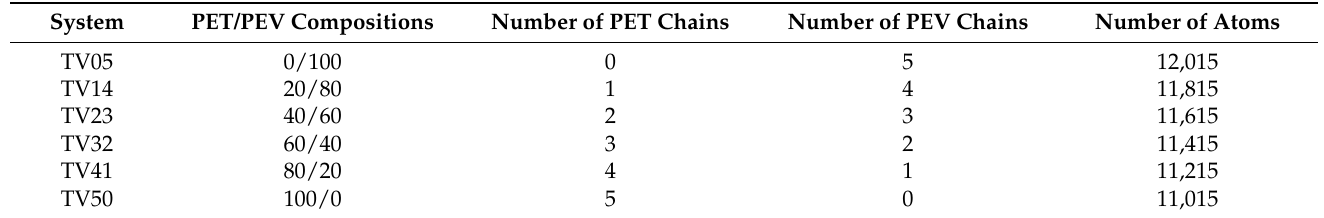
Table 1. Simulation details of six systems: PEV, PET, and their blends with different